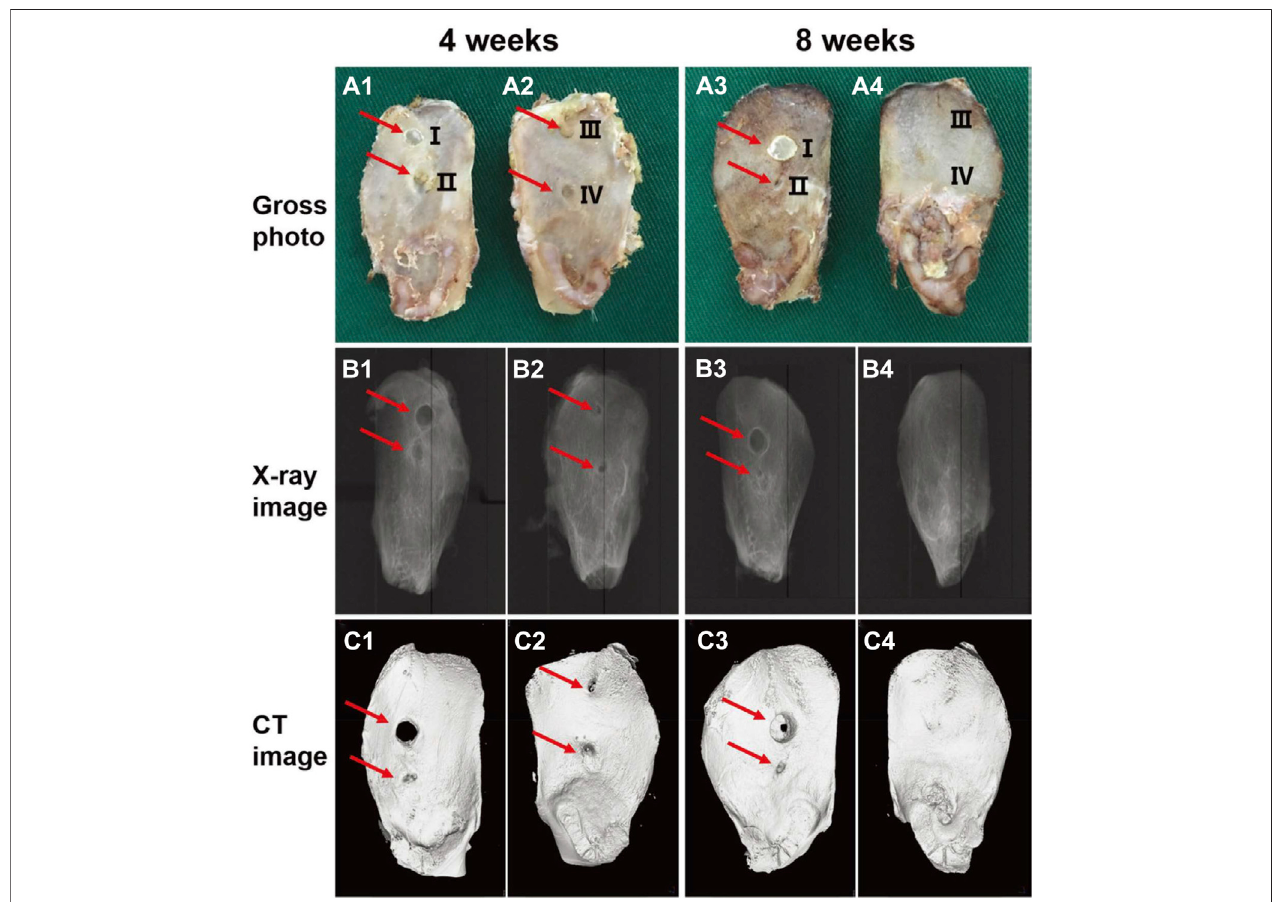
FIGURE 2 | Representative gross photograph (A1 – A4) , radiophograph (B1 – B4) , and micro-CT scan images (C1 – C4) of the ilium bone defects of New Zealand rabbits receiving no treatment (III) or treated with bone wax (I), CHI-C solution (II), or CHI-C/DACNC hydrogel (IV) after 4 and 8 weeks of surgery. The CHI-C/DACNC group shows more abundant bone formation than other groups. Reproduced from (Huang et al., 2021a) with permission from Copyright 2021 Wiley.